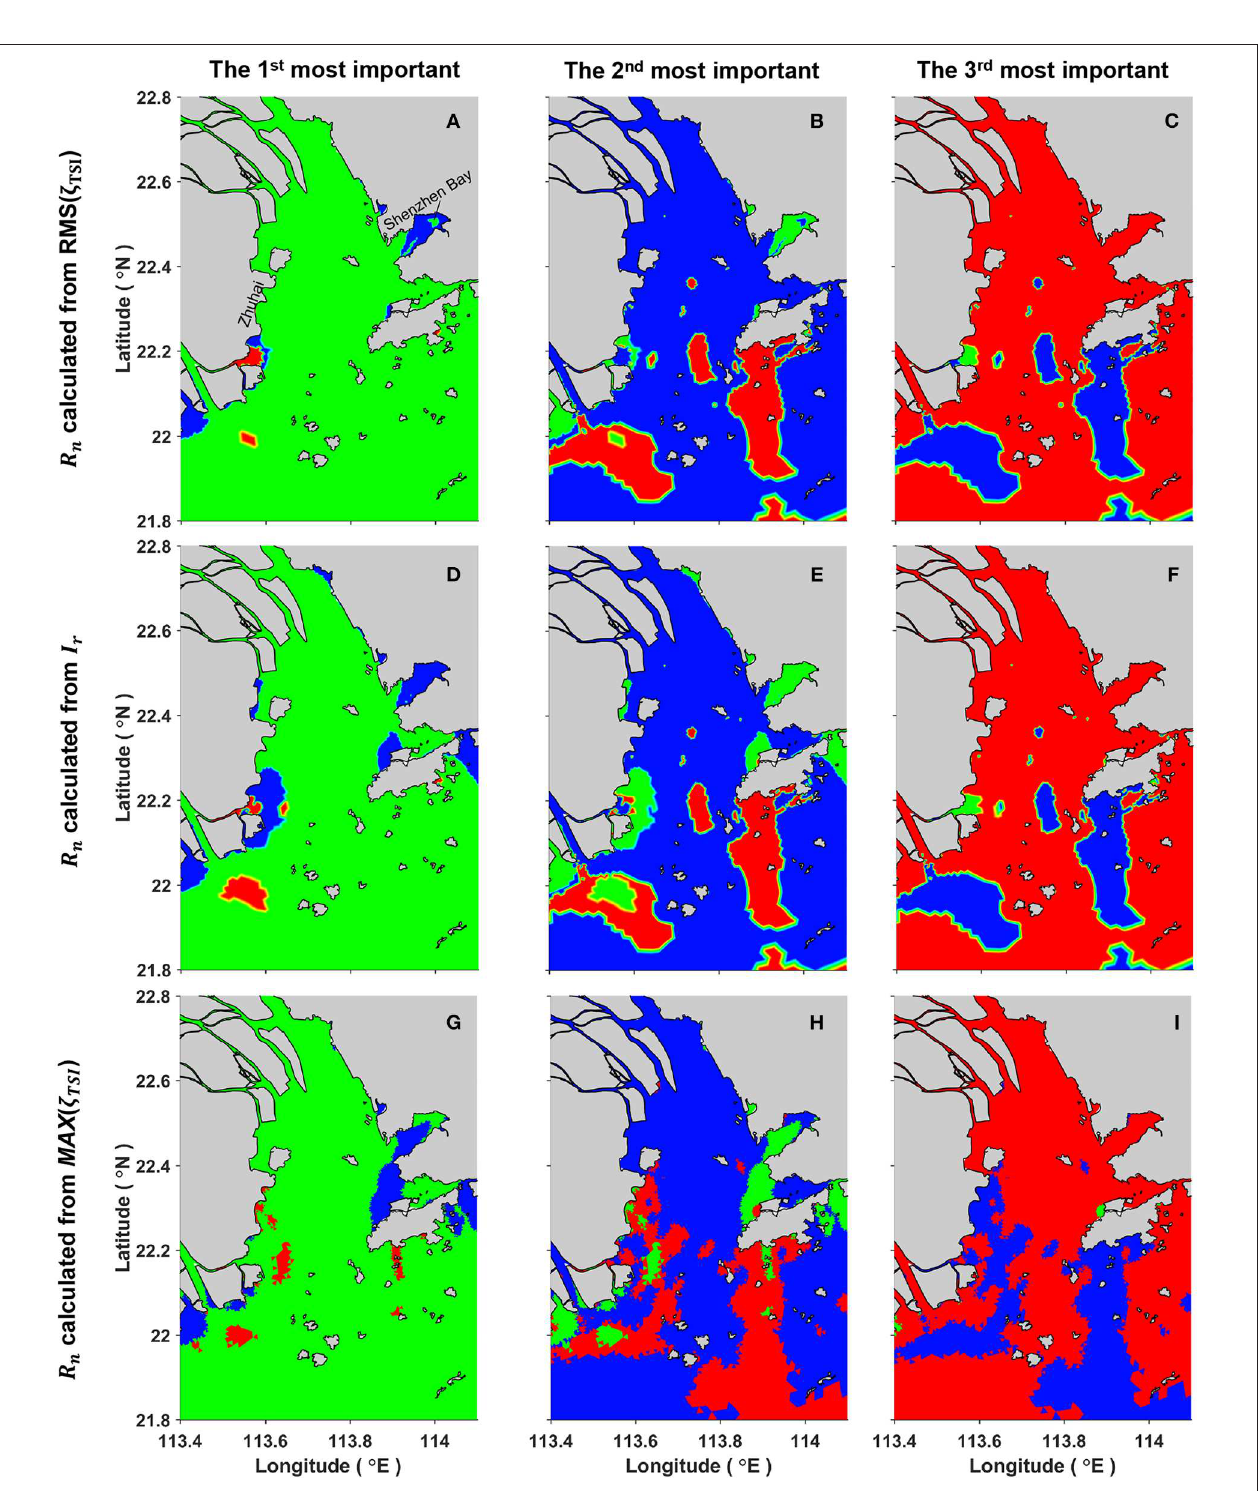
FIGURE 11 | The first (A,D,G) , second (B,E,H) , and third (C,F,I) most important non-linear effects in the tide-surge interaction in the PRE. Green represents the quadratic bottom friction; blue represents the shallow water effect; and red represents the nonlinear advective effect. (A–C) Use RMS ( ζ TSI ) to calculate R n , (D–F) use I r to calculate R n , and (G–I) use MAX ( ζ TSI ) to calculate R n .